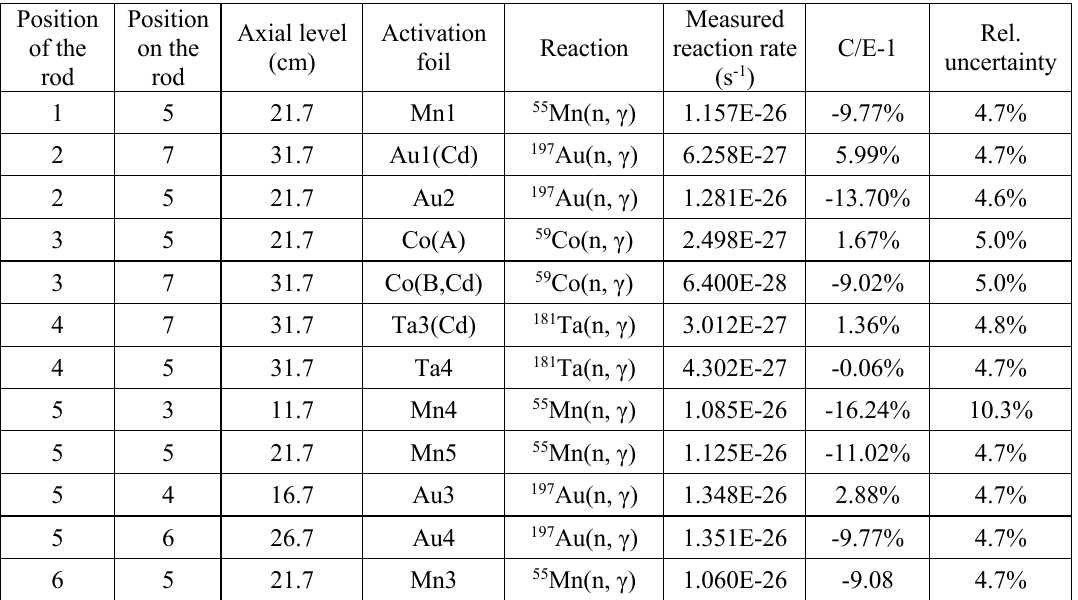
Table III. Measured and calculated reaction rates in the FLIBE module normalized to one target nucleus and neutron in the core .